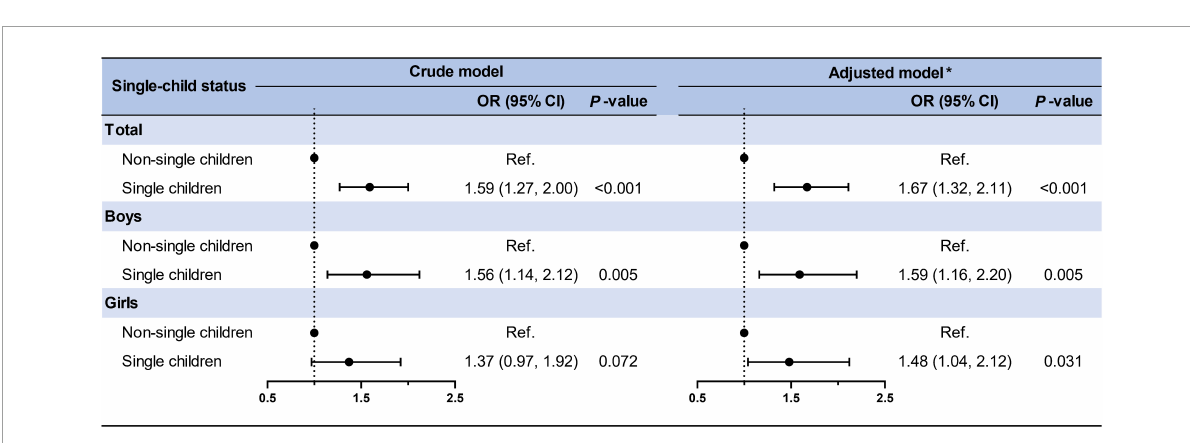
FIGURE2 Association between single-child status and clustered CMRFs in children and adolescents. *Adjusted for age, residence, family history of diseases (obesity, hypertension, diabetes mellitus, and cerebrovascular disease), parental education level, parental tobacco, and alcohol consumption and the clustered effect of